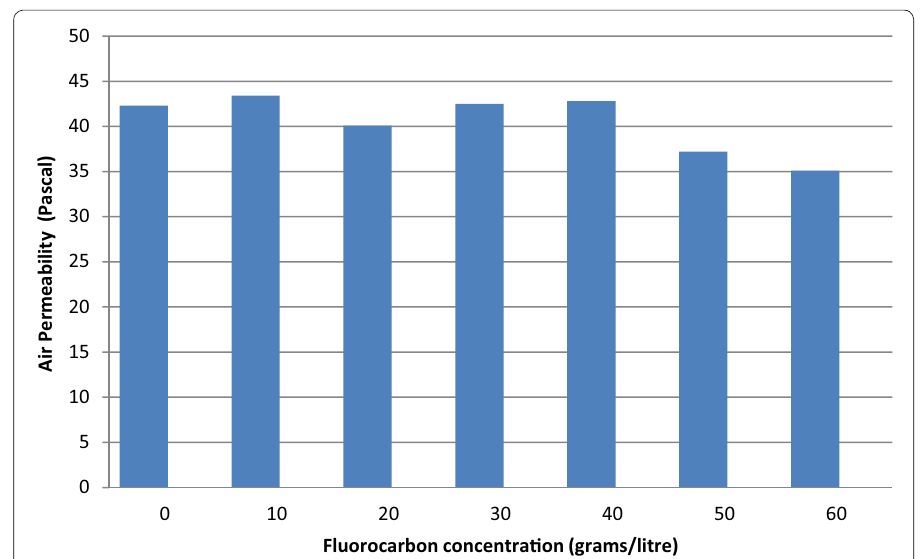
Fig. 4 Comparison of air permeability of untreated (0 g/L) and treated cotton with fluorocarbon at 10 to 60 g/L. Air permeability of untreated and treated